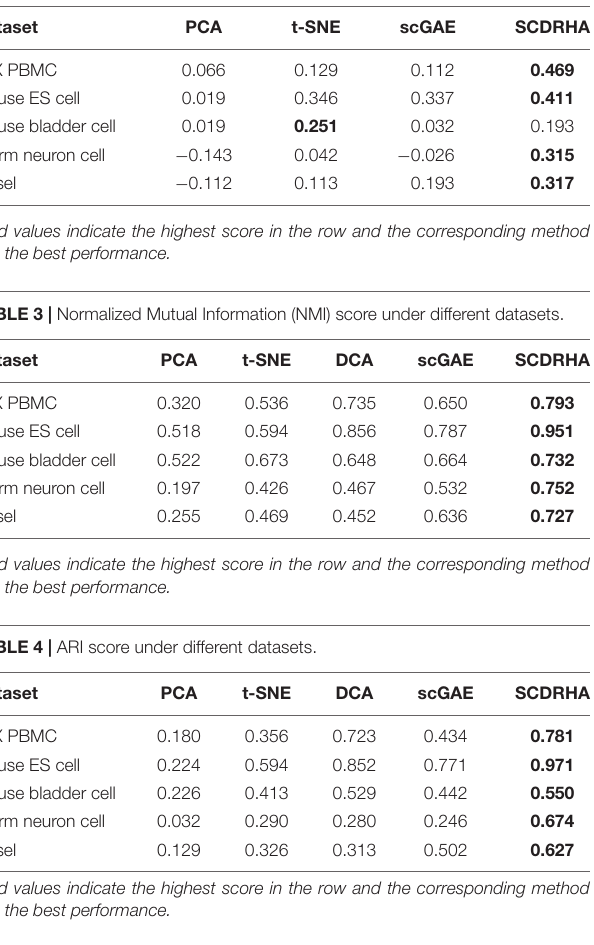
TABLE 2 | Average silhouette value under different datasets.